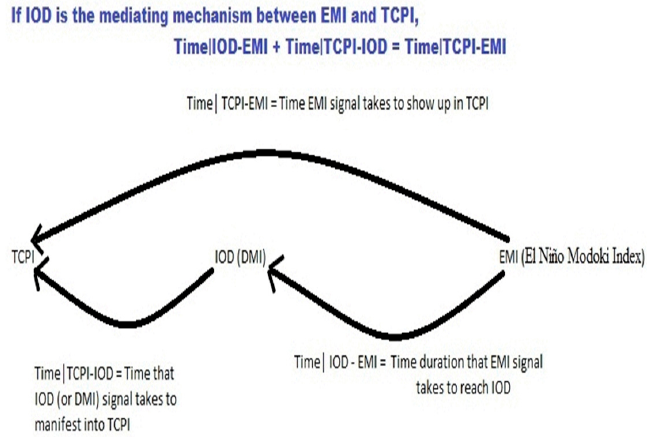
Figure 9. IOD as a mediating mechanism between the El Niño Modoki and tropical cyclones over the North Indian Ocean.